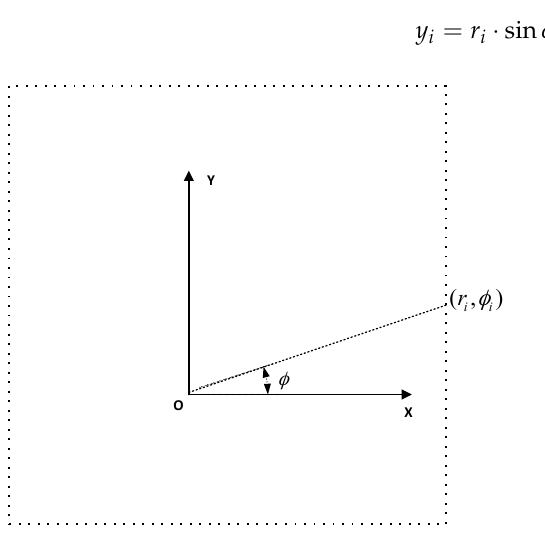
Figure 4. Laser ranger scans from a square structure